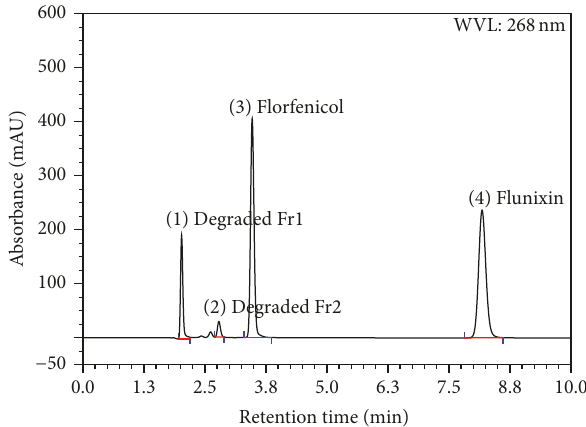
Figure 3: Chromatogram of stress testing of Flr and Flx under basic hydrolysis condition of 0.02 N NaOH, at RT for 2 hours.